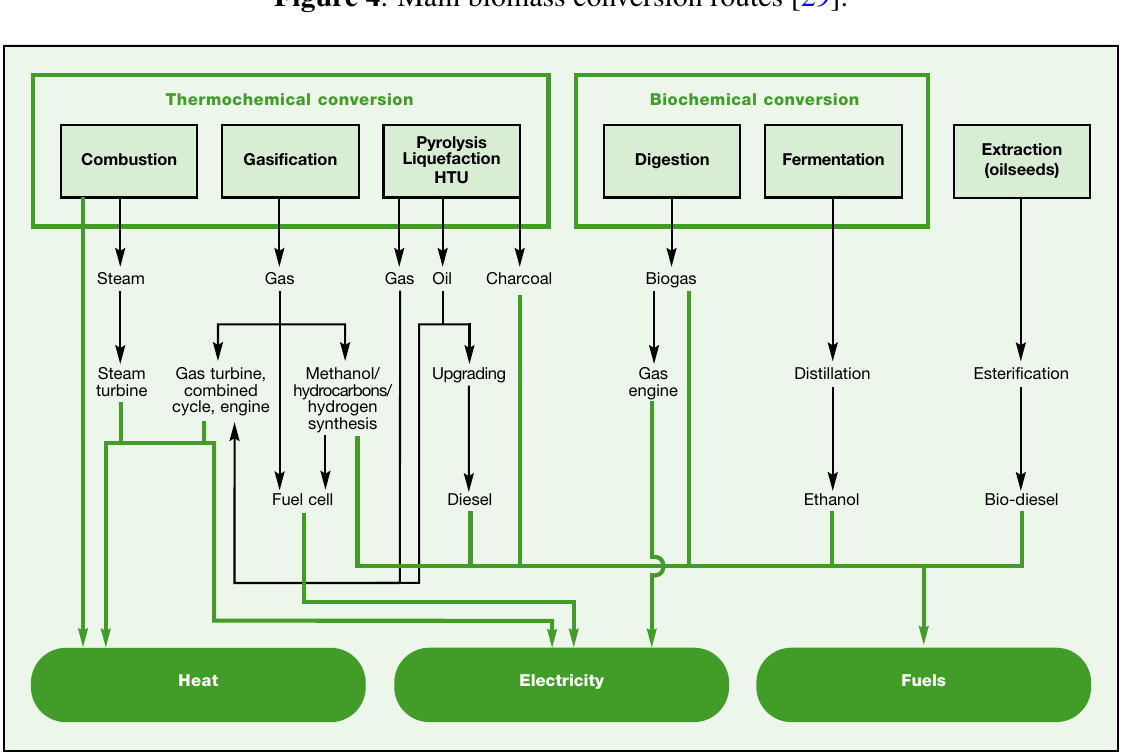
Figure 4 . Main biomass conversion routes